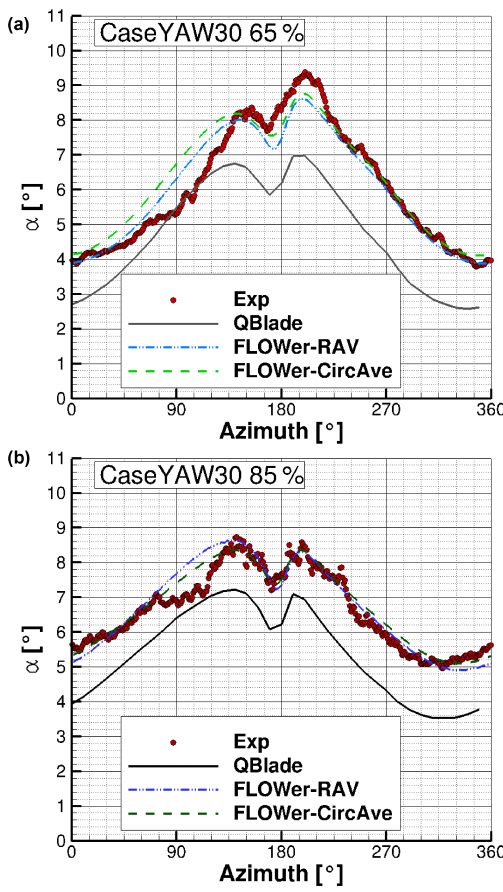
Figure 18. AoA distribution over the azimuth for CaseYAW30 for the experiment, QBlade and FLOWer (RAV and CircAve) at 65% R (a) and 85% R (b) .